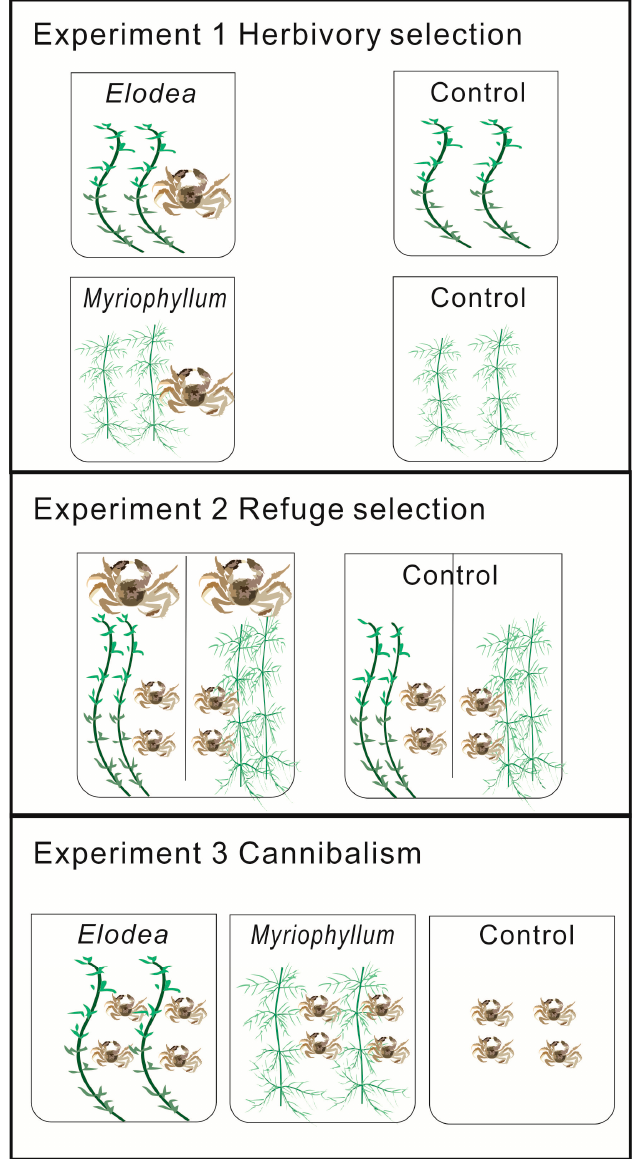
Figure 2. Experimental design. In all experiments, each treatment consisted of three replicates. Experiment 1: One adult crab was put in each tank for 10 days. Tanks without adult crabs served as controls. Experiment 2: One adult crab and five juveniles were put in each side of the tank for 7 days. Tanks without adult crabs served as controls. Experiment 3: Twenty juveniles were put in each tank for 60 days. Tanks without plants served as controls.